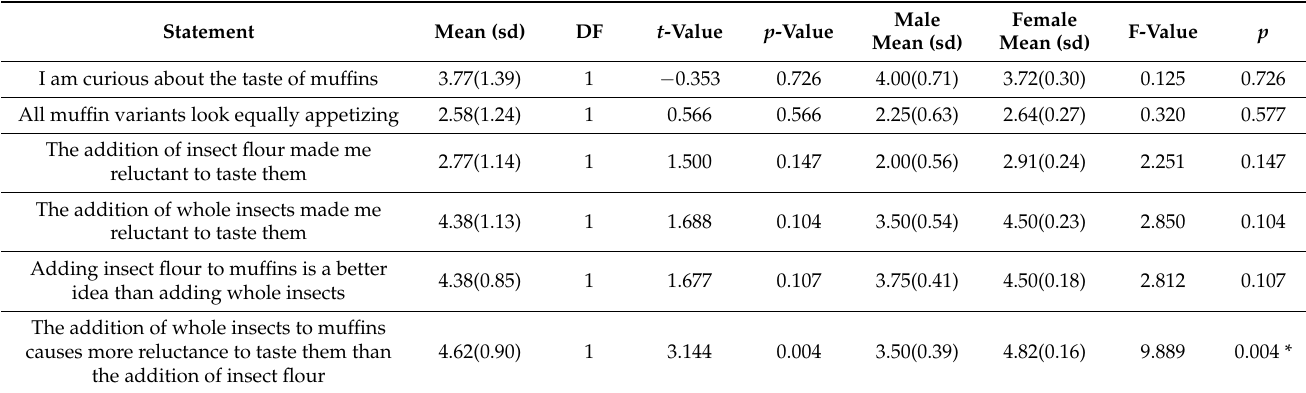
Table 5. Results of statements before the sensory evaluation of the muffins (1 = strongly disagree; 5 = strongly agree) on the total sample and by gender.